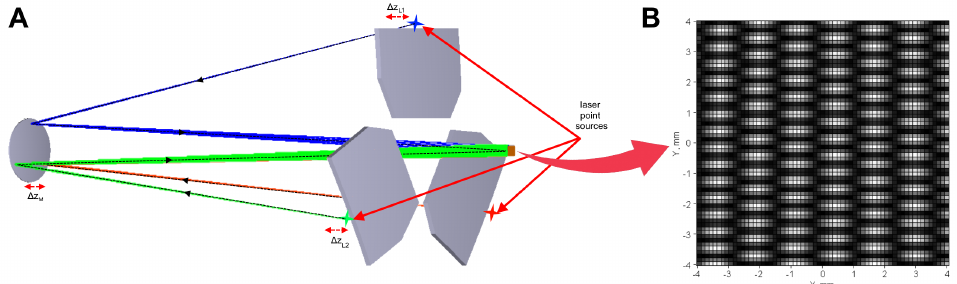
Figure 5. Operation of the digital holographic positioning sensor: ( A ) illumination of the telescope focal plane by the auxiliary laser sources; ( B ) sample interferogram recorded with pixel